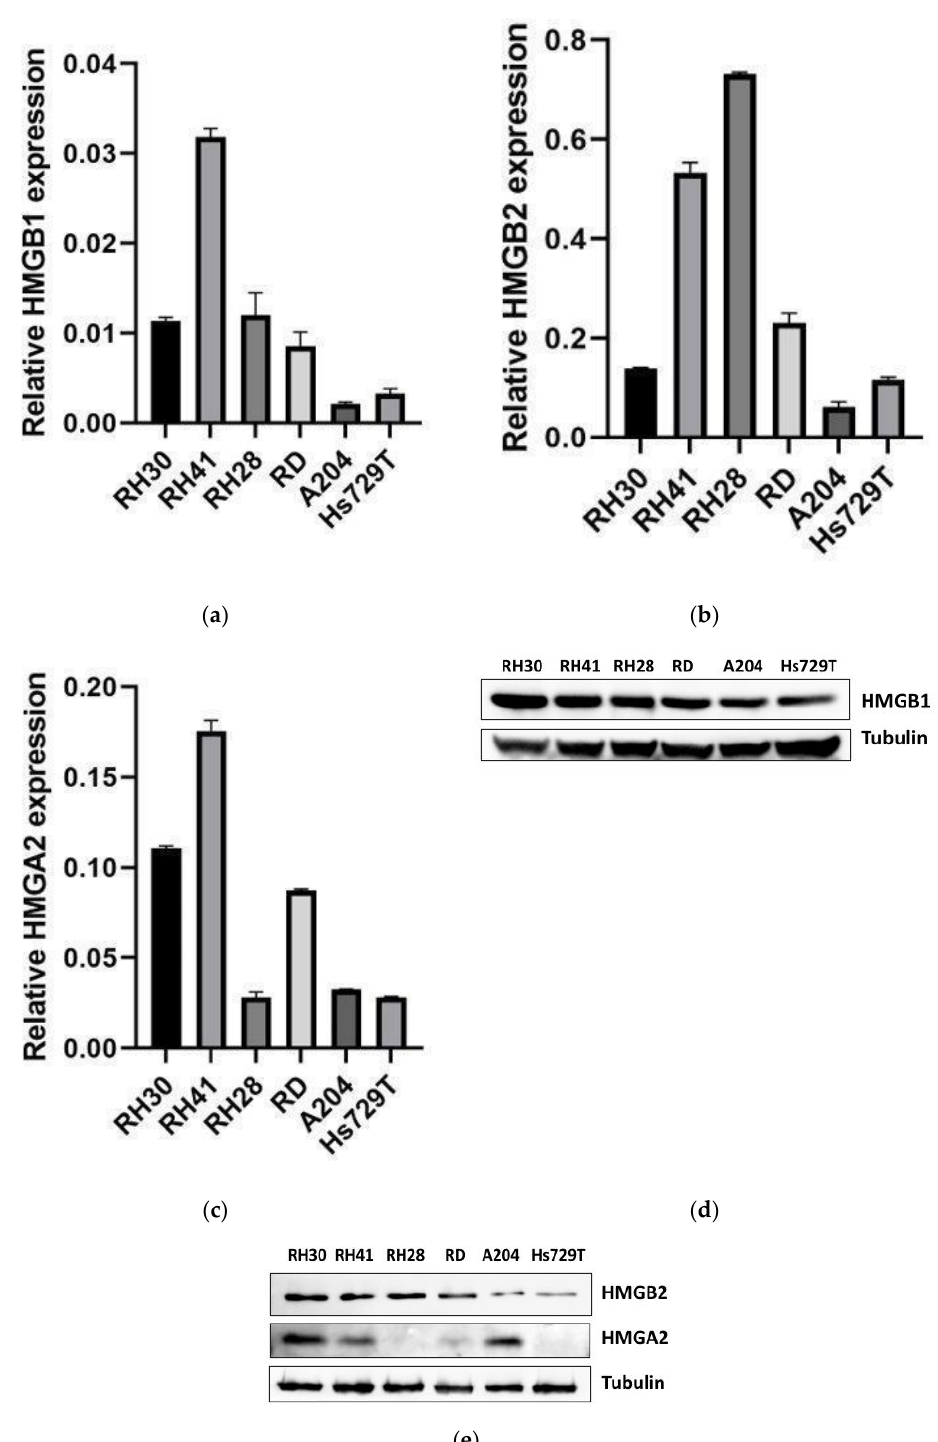
Figure 3. HMGB1, HMGB2 and HMGA2 expression in RMS cell lines. HMGB1 ( a ), HMGB2 (b ) and HMGA2 ( c ) gene expressions in six RMS cell lines were analyzed by qPCR and normalized by GAPDH expression. RNA was extracted from each cell line 48 h after being seeded. HMGB1 ( d ), HMGB2 and HMGA2 ( e ) protein levels in RMS cell lines were analyzed by immunoblot using the specific antibodies for each protein and normalizing them by tubulin. The data from one of three independent experiments are shown. RH30, RH41 and RH28: alveolar rhabdomyosarcoma cell lines. RD, A204 and Hs729T: embryonal rhabdomyosarcoma cell